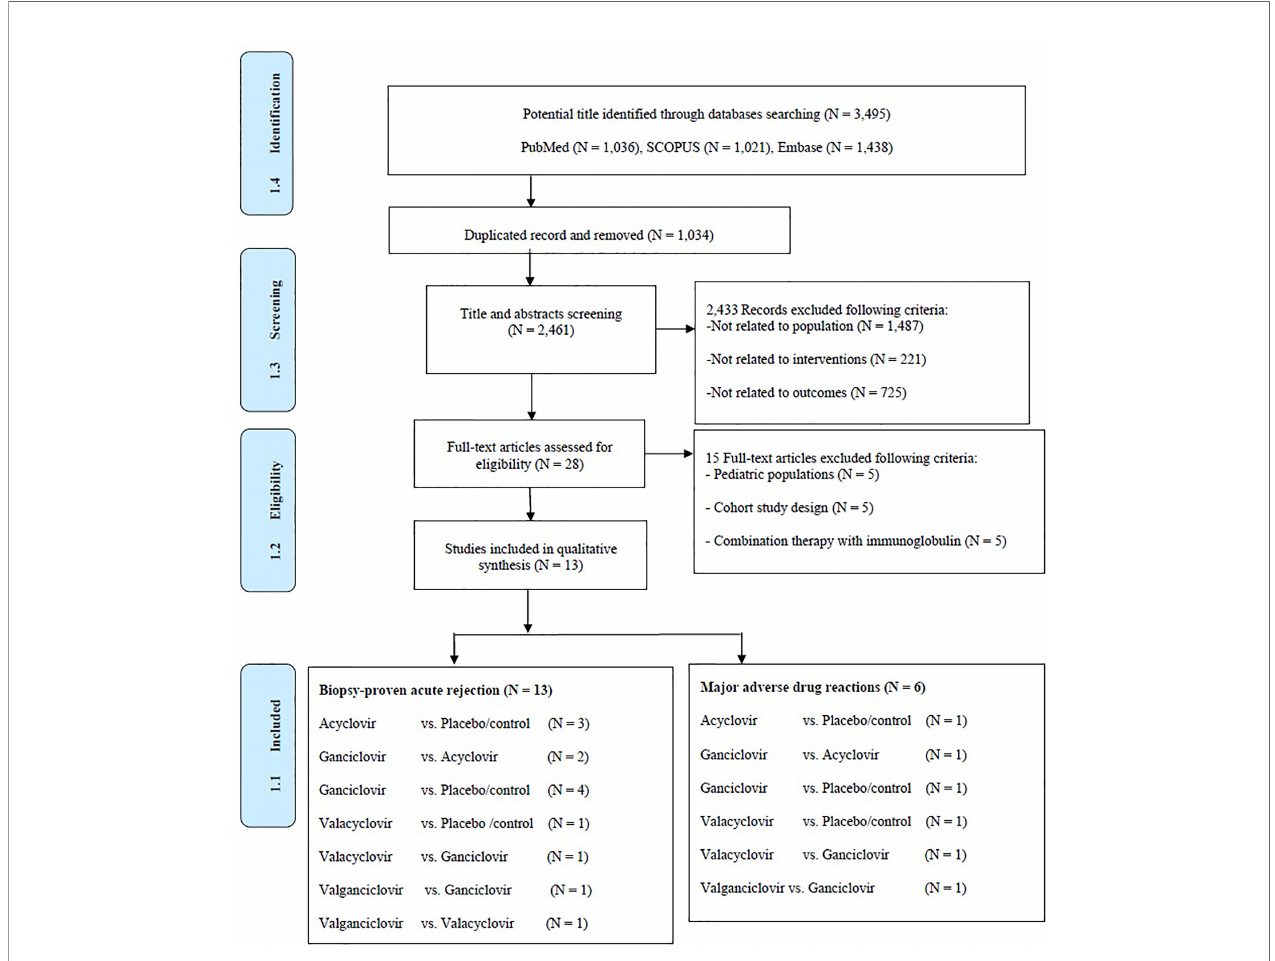
FIGURE 1 | Preferred reporting items for systematic reviews and meta-analyses for network meta-analysis extension or PRISMA-NMA fl ow diagram of screening